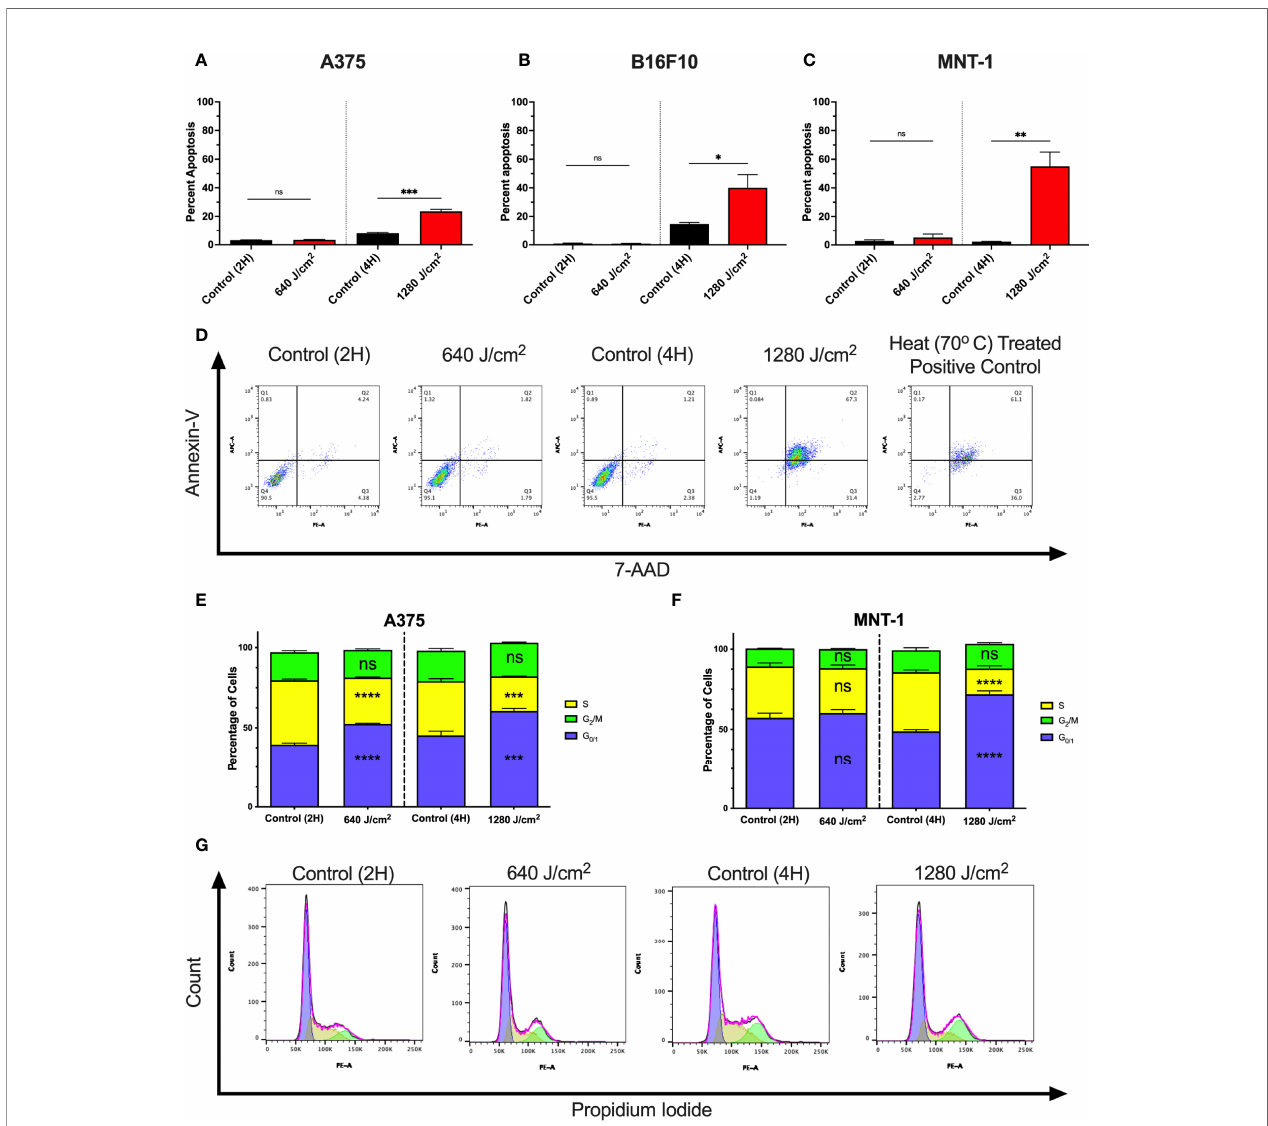
FIGURE 2 | RL increases cell death and alters the cell cycle. (A) Cell death was con fi rmed in A375 (n=3), (B) B16F10 (n=5), and (C) MNT-1 (n=5) melanoma cells using annexin-v and 7-AAD fl ow cytometry. (D) Representative fl ow plots for annexin-V and 7-AAD. A heat-treated positive control (70°C) was used for gating. (E) Cell cycle progression was assessed using PI fl ow cytometry in A375 (n=3) and (F) MNT-1 (n=3) cells. The percentage of cells in each phase was modeled using the Watson pragmatic model in FlowJo. (G) Representative cell cycle phase histograms from the A375 cell line. Apoptosis and cell cycle distribution compared RL and time-matched control groups using a two-tailed T-Test (p<0.05). 2H, 2 hours; 4H, 4 hours; PI, propidium iodide; 7-AAD, 7-Aminoactinomycin D; and RL, red light. *denotes p<0.05, ** denotes p<0.01, *** denotes p<0.001, **** denotes p<0.0001, and ns denotes